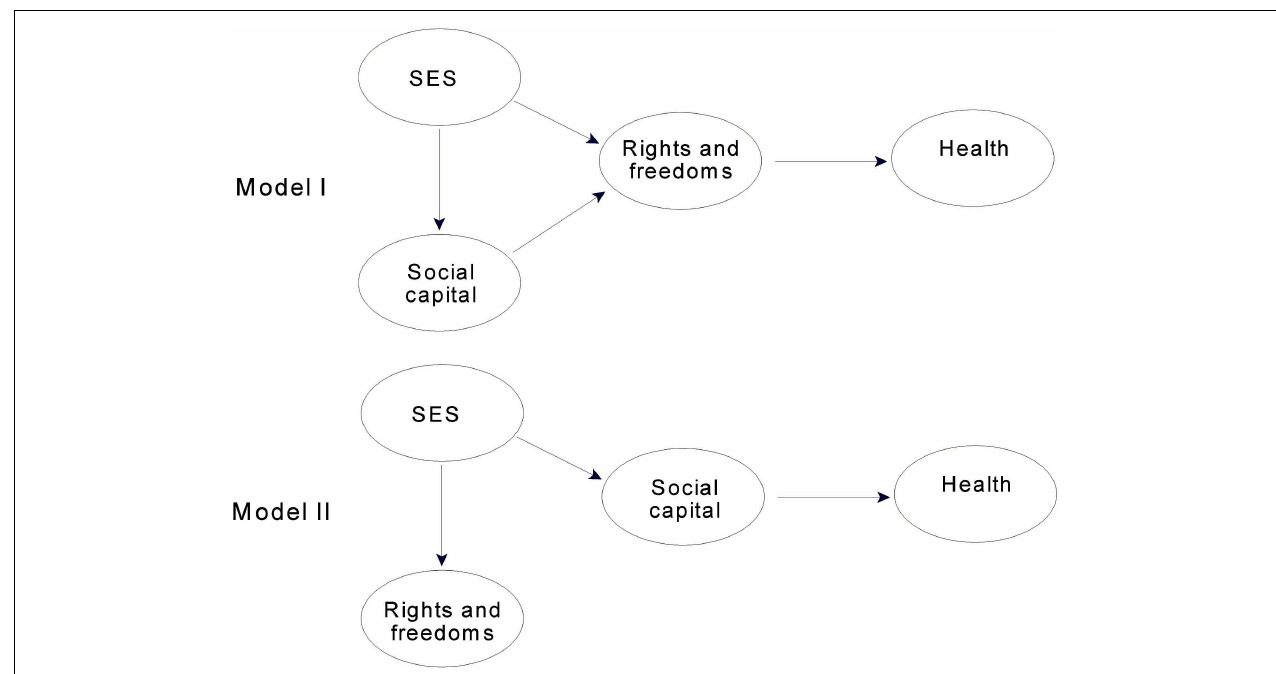
FIGURE 3 | Contrasting conceptual path models for evaluating direct and mediated effects for social capital, and rights and freedoms for the 23 countries with available social capital